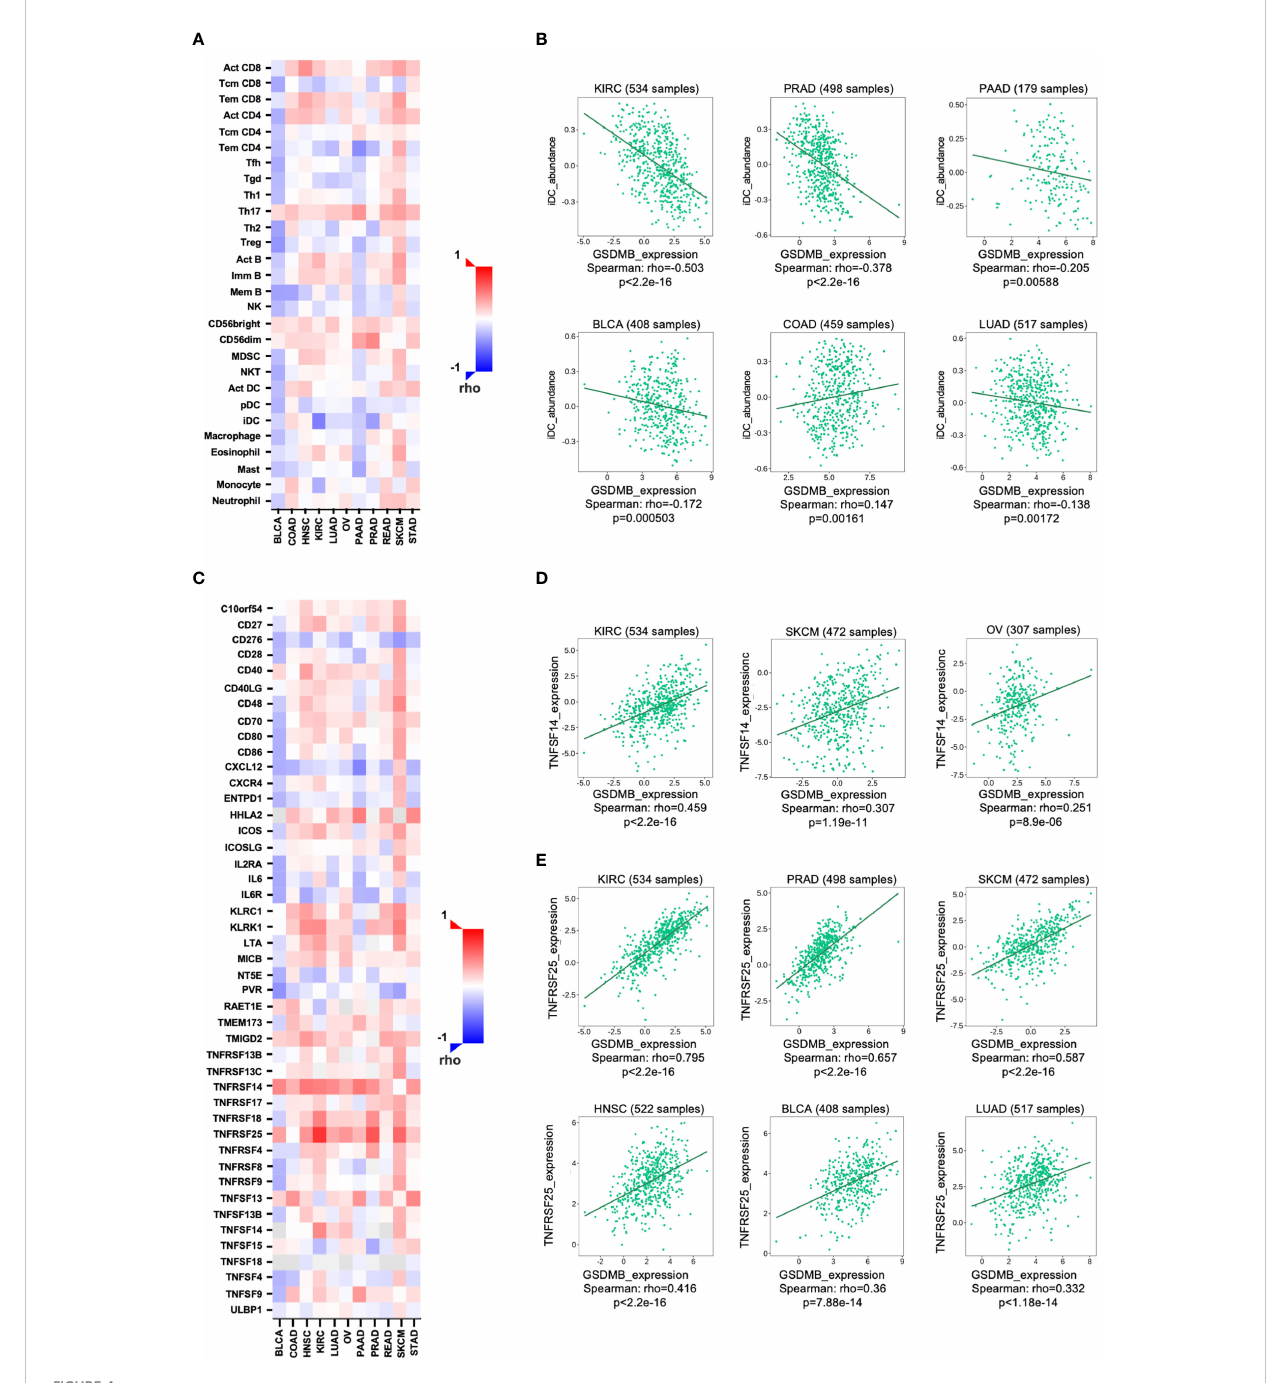
FIGURE 4 The relationship between GSDMB expression and two kinds of immunomodulators. (A) Spearman ’ s correlations between GSDMB and TILs across human cancers. (B) Representative correlation dot plots for iDCs. The expression of GSDMB gene in KIRC has the most signi fi cant negative correlation with iDCs. (C) Spearman ’ s correlations between GSDMB and immunostimulators across human cancers. Representative correlation dot plots for TNFSF14 (D) and TNFRSF25 (E) . The expression of GSDMB gene in KIRC has the most signi fi cant positive correlation with TNFSF14/ TNFRSF25. Spearman ’ s correlations: the value in the following heatmap represents the rho value. GSDMB, gasdermin B; TILs, tumor-in fi ltrating lymphocytes; iDCs, immature dendritic cells; KIRC, kidney renal clear cell